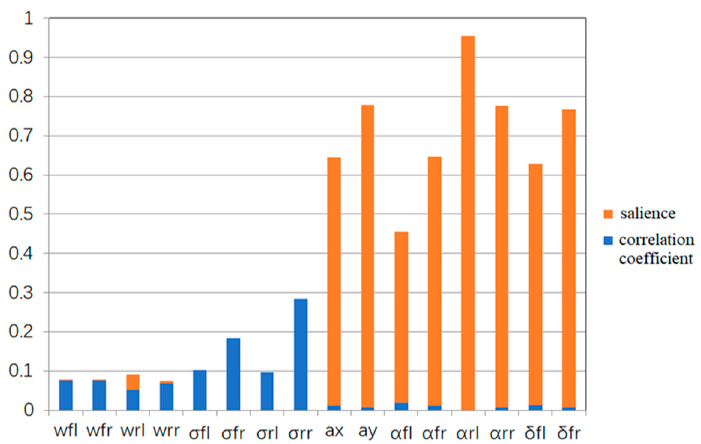
Figure 2. The Spearman principal component analysis related to μ .